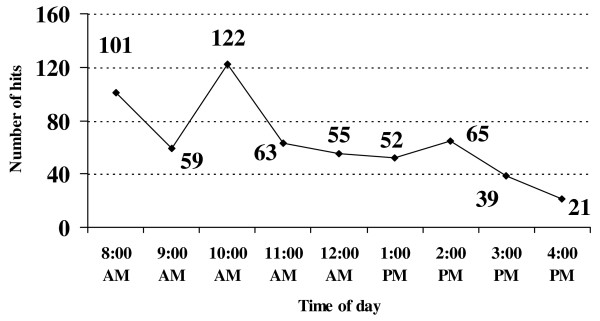
Hourly Access to NLM Server. Number of hits to NLM server hourly from 8 am to 4 pm during the study period